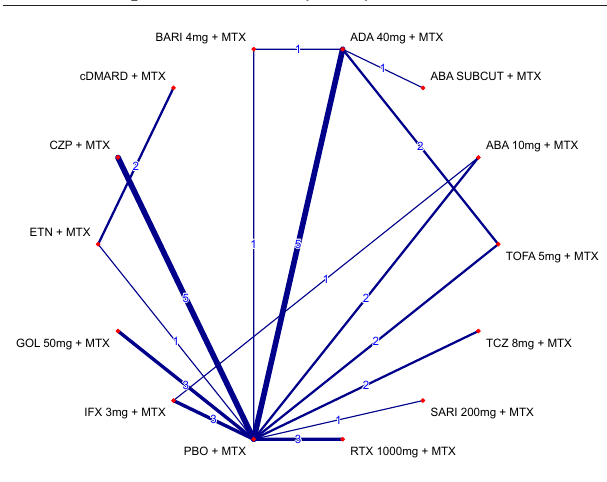
Figure 4. Network of Evidence for ACR20 Response at Week 24 (MTX-IR Population; Sensitivity Analysis